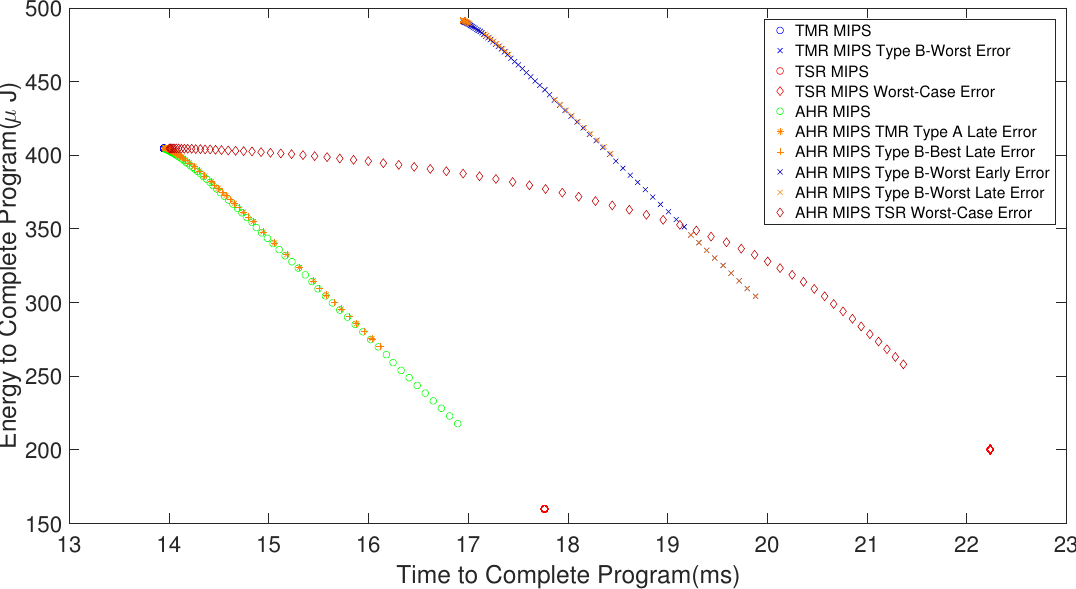
Figure 16. TMR to TSR transition varying from 11,000 to 80,000 instructions: energy vs. time to